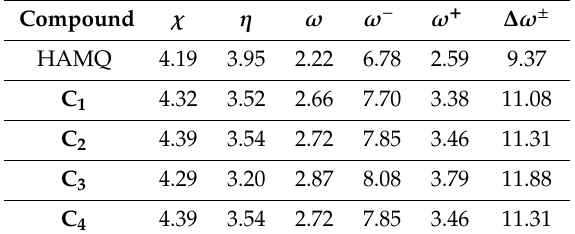
Table 4. Global reactivity descriptors (in eV) of the HAMQ ligand and its four metallic complexes calculated with the aid of the MN12SX / Def2TZVP / DMSO model chemistry. Compound χ η ω ω − ω + ∆ ω ±